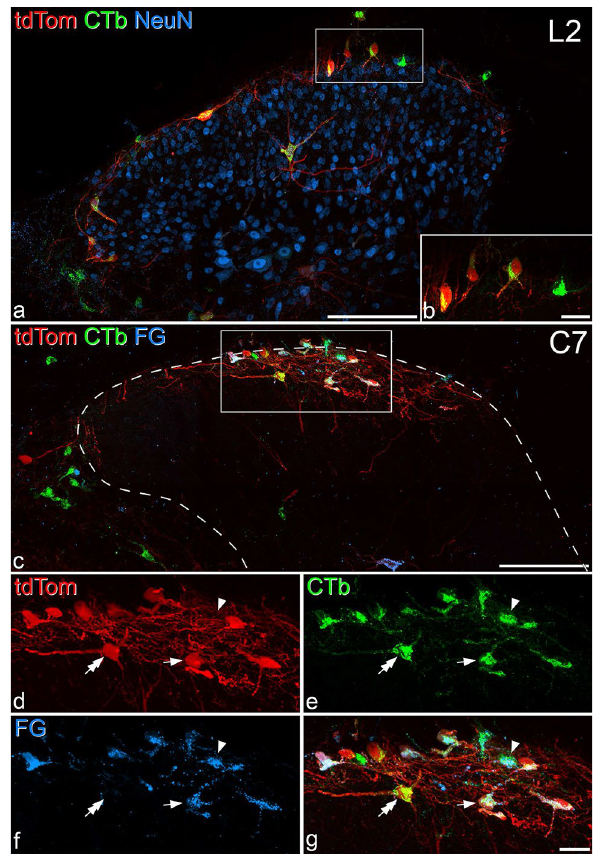
Figure 2. The relationship between retrograde labelled and Phox2a-positive cells. ( a ) Transverse section through the L2 segment of experiment #4, showing the side contralateral to the cholera toxin B subunit (CTb) injection into the lateral parabrachial area. The section has been immunostained to reveal tdTomato (tdTom, red), CTb (green) and NeuN (blue). Several retrogradely labelled neurons are visible, and most of these are in lamina I. Several of these are also tdTom-positive, and therefore appear yellow. The box shows the region corresponding to ( b ). ( b ) Part of lamina I from the same section showing 4 retrogradely-labelled lamina I cells, which contain CTb in the cytoplasm. The one on the right side is negative for tdTom, while the other three are tdTom-positive. ( c ) Transverse section through the C7 segment of experiment #6, showing the side contralateral to the CTb and Fluorogold (FG) injections. The section has been stained to reveal tdTom (red), CTb (green) and FG (blue). There is a cluster of retrogradely labelled cells, many of which are tdTom-positive in the central part of lamina I. The dashed line shows the outline of the grey matter, and the box indicates the region shown at higher magnification in ( d – g ). ( d – g ) Separating the individual colours reveals several patterns of co-localisation, including CTb-positive cells that also contain FG and tdTom (example shown with arrow). There are also tdTom-negative cells that are labelled with both CTb and FG (example shown with arrowhead) and CTb-labelled tdTom-positive cells that lack FG (example shown with double arrow). All images are from maximum intensity projections of confocal image scans (1 μm z-separation) through the full thickness of the 60 μm sections. In both ( a,c ), medial is to the right. Scale bars: ( a,c ) = 100 μm; ( b,d – f ) = 20